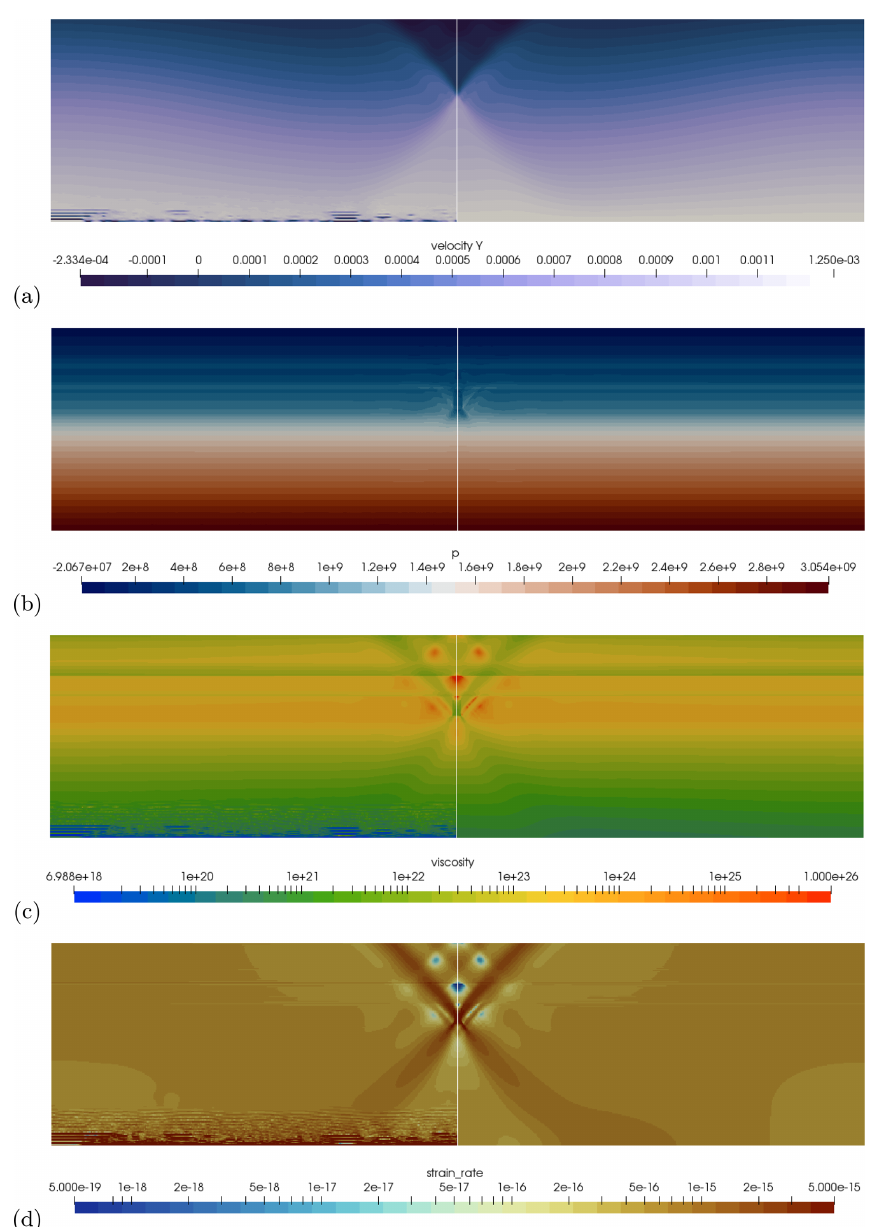
Figure 14. Application example. (a) Vertical component of the velocity field; (b) pressure field; (c) effective viscosity field; (d) effective strain rate field. In all panels, the left half (left of the vertical line) shows data obtained with the stabilized Q 1 × Q 1 element, whereas the right half shows results obtained with the Q 2 × Q 1 element. Note the large deviations between the two towards the bottom of the domain. All results were obtained on an 800 × 200 mesh with a cell size of